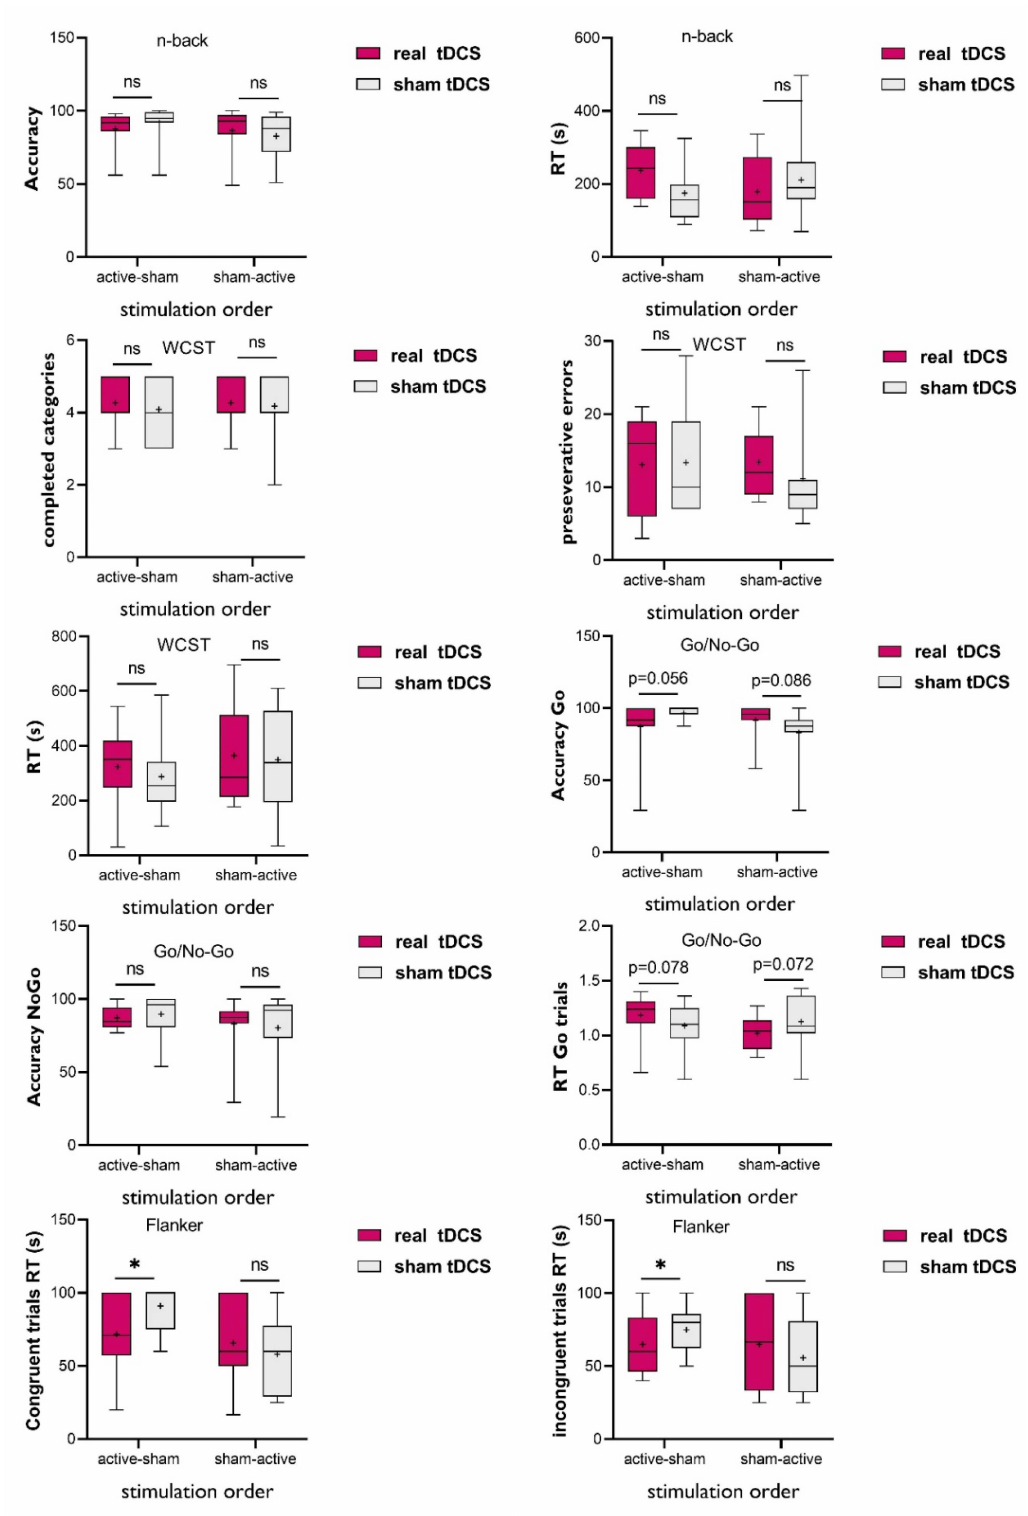
Figure 1. Executive functioning performance under bilateral DLPFC, anodal tDCS and sham tDCS, in children with ADHD. tDCS = transcranial direct current stimulation; RT = response time; S = second; WCST = Wisconsin Card Sorting Test; ns = non-significant. * = refers to significant difference between the real tDCS vs sham